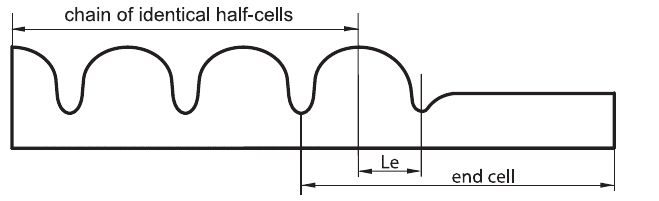
FIG. 13. Half-cavity with the type b end cell. FIG. 15. (Color) Normalized R sh for the type a end cells.